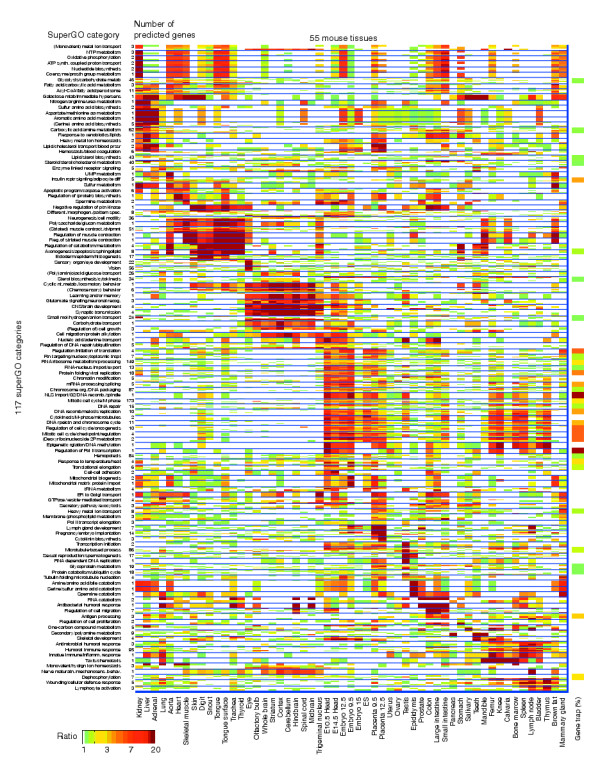
Expression patterns of 1,092 unannotated genes predicted to belong to any of 117 'superGO' categories with 50% confidence or higher. The vertical axis was clustered and diagonalized as in Figure 4. The height of each predicted category has been normalized to facilitate display; the number of genes predicted in each category is indicated at the left. The gene order (vertical axis) has been clustered within each category to illustrate that some categories are characterized by multiple patterns. The proportion (%) of predicted genes in each category that have gene-trap ES cell lines available are represented at right (color scale from 0 to 100%).